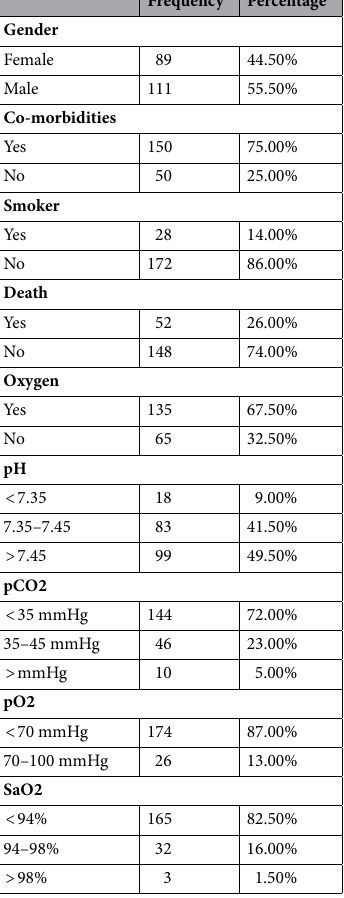
Table 1. Demographic features of the studied